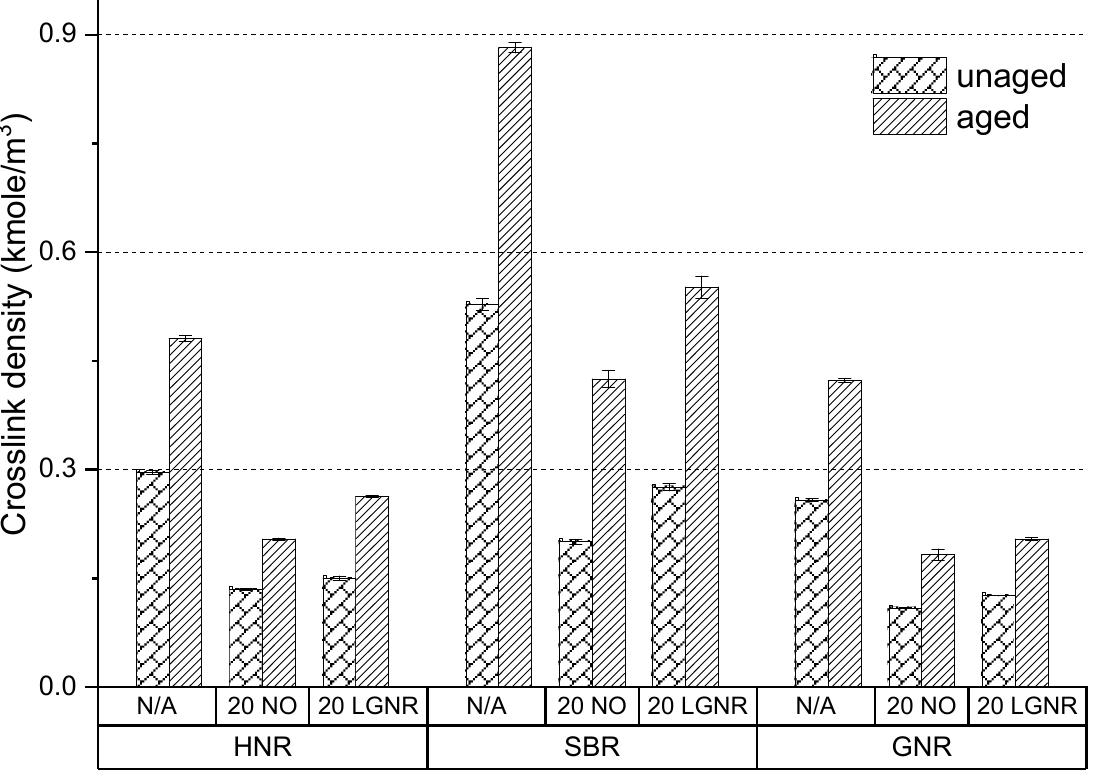
Figure 19. Aging effects on the crosslink density of HNR, SBR and GNR composites made with or without processing aids. N/A: rubber compounds without processing aids; 20 NO: rubber compounds with 20 phr naphthenic oil; 20 LGNR: rubber compounds with 20 phr liquid guayule natural rubber.